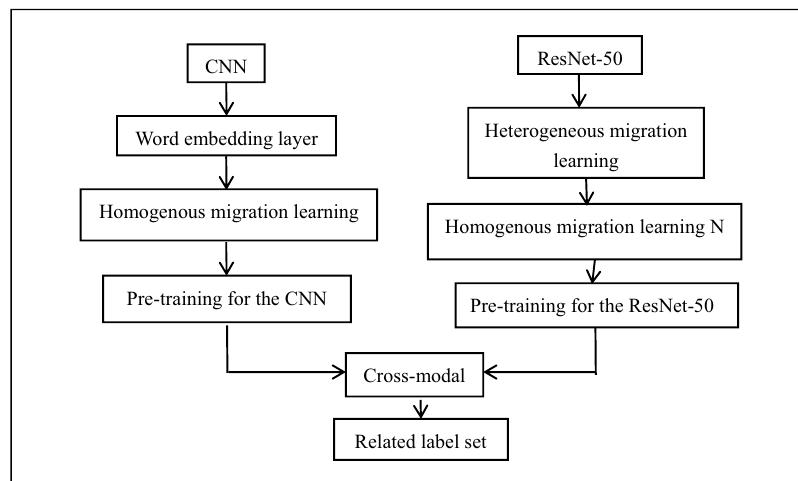
Figure 1: Architecture of cross - modal multi - label classi fi cation